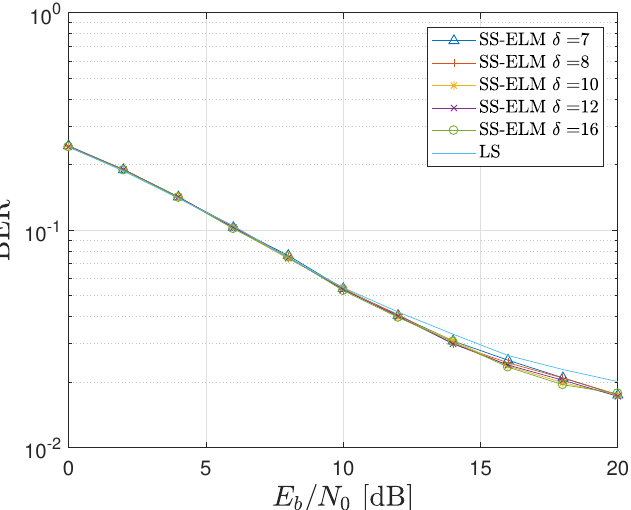
Figure 13. BER of the proposed SS-ELM scheme with δ as parameter and the LS algorithm for system configuration